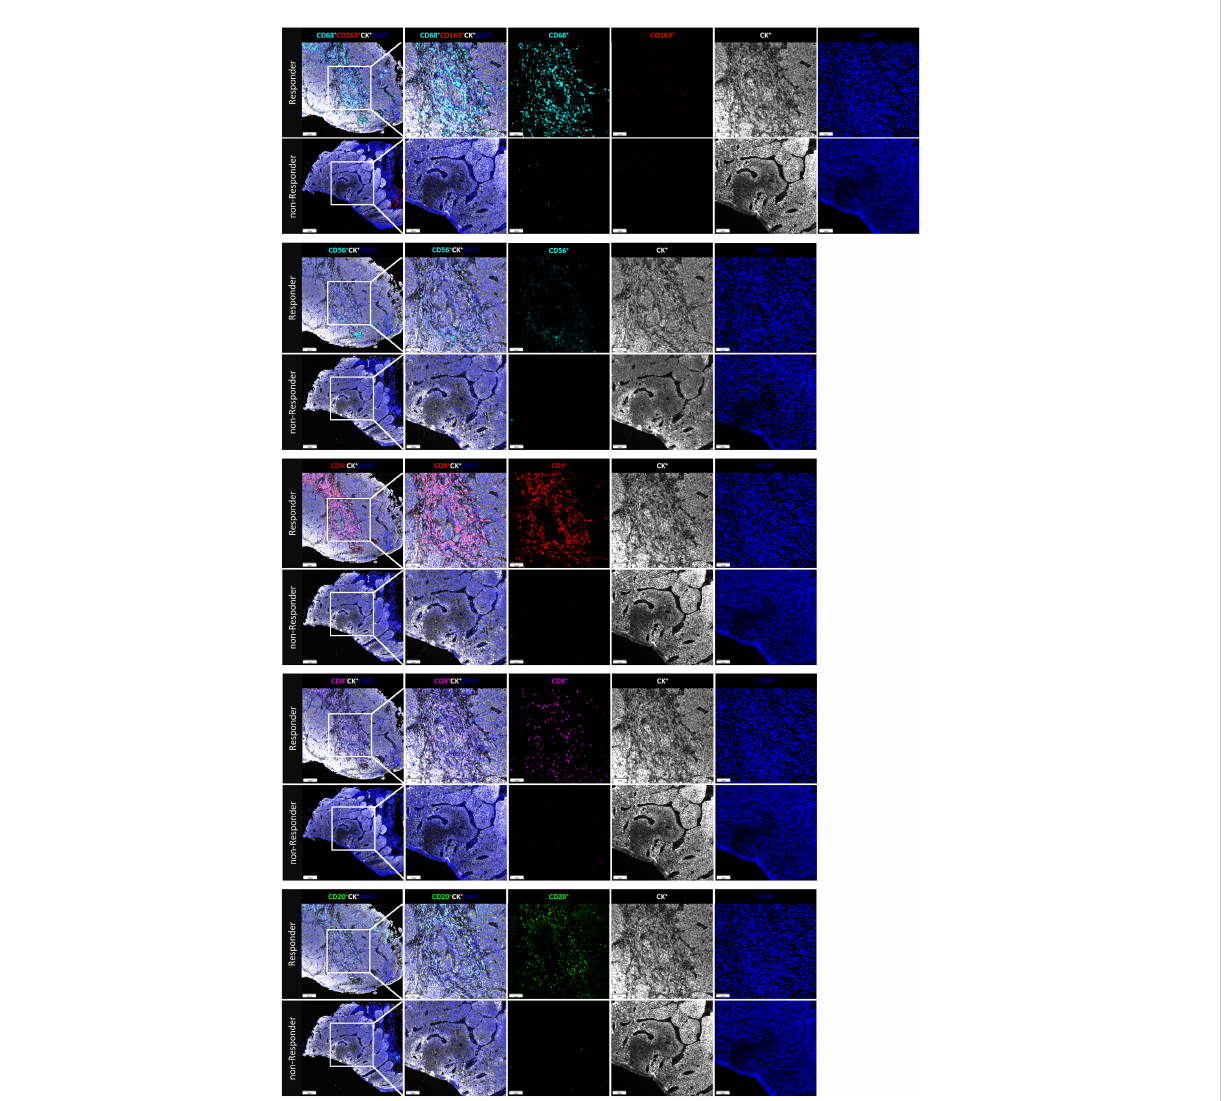
FIGURE 5 The immune cell biomarkers of tumor tissue samples from representative patients brfore treated with neoadjuvant immunochemotherapy. In responder and nonresponder, tissues from ESCC patients were stained with multiplex immuno fl uorescence for immune cell biomarkers, indicated by distinct colors. The density and percentage of CD68 + CD163 - , CD68 + CD163 - , CD56 + , CD4 + , CD8 + , and CD20 + immune cells in the tumor center or stroma were analyzed from top to bottom. Representative images showing the multiplex immuno fl uorescence staining for identifying the immune cell subsets in the tumor immune microenvironment; Tissue-1: CD68, cyan, opal 480; CD163, red, opal 620; CD8, magenta, opal 690; Tissue-2: CD56, cyan, opal 480; CD4, opal 520, red; CD20, Green, opal 620; Two tissue samples were utilized for analysis; Multiplex stained slides were scanned using a Vectra Polaris Quantitative Pathology Imaging System (Akoya Biosciences) at 20 nm wavelength intervals from 440 nm to 780 nm. All scans for each slide were then superimposed to obtain a single